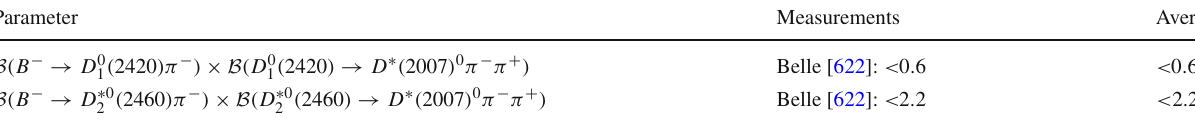
Table 142 Absolute product decay rates to excited D mesons II [ 10 − 5 ]